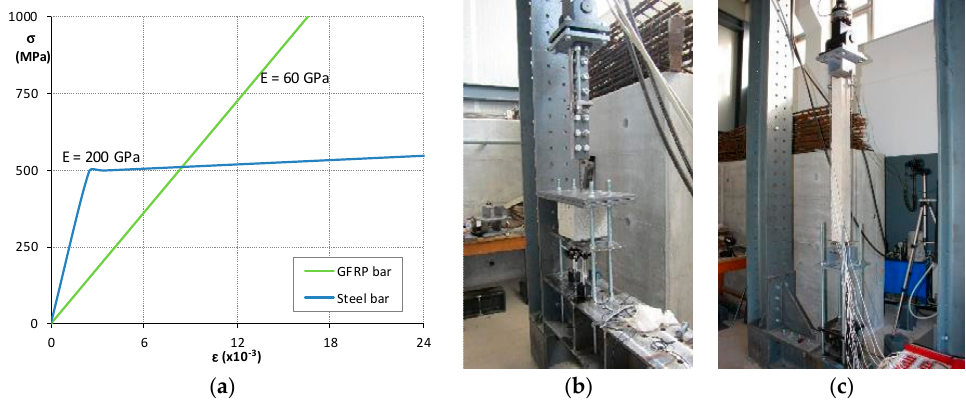
Figure 5. ( a ) Stress-strain relation of steel and glass fibre–reinforced polymer (GFRP) rebars; ( b ) Pull-out tests; ( c ) Tensile tests of reinforced ties.